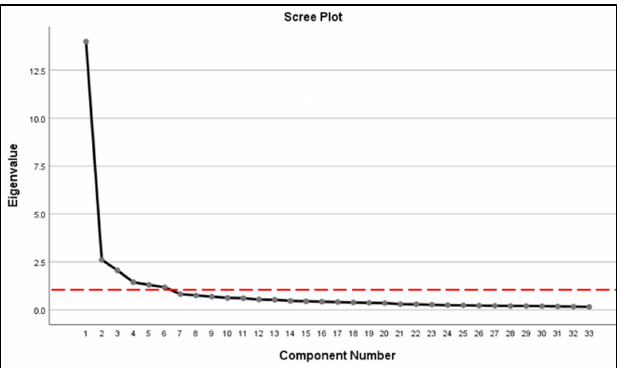
Figure 1. Number of major components.